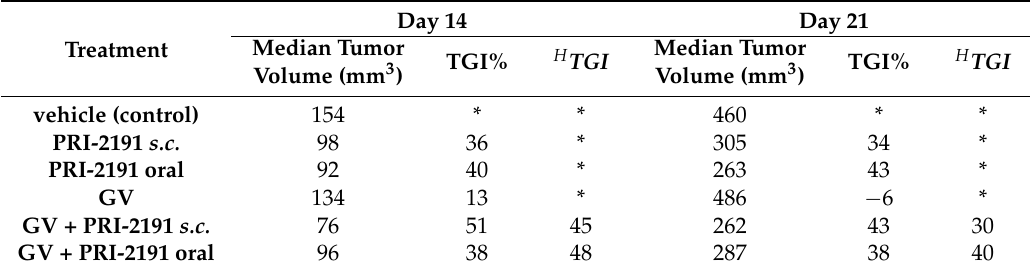
TGI, tumor growth inhibition; H TGI , hypothetical tumor growth inhibition; GV, imatinib; PRI-2191 and PRI-2205, vitamin D analogs; s.c. , subcutaneous injection; oral, oral gavage; *